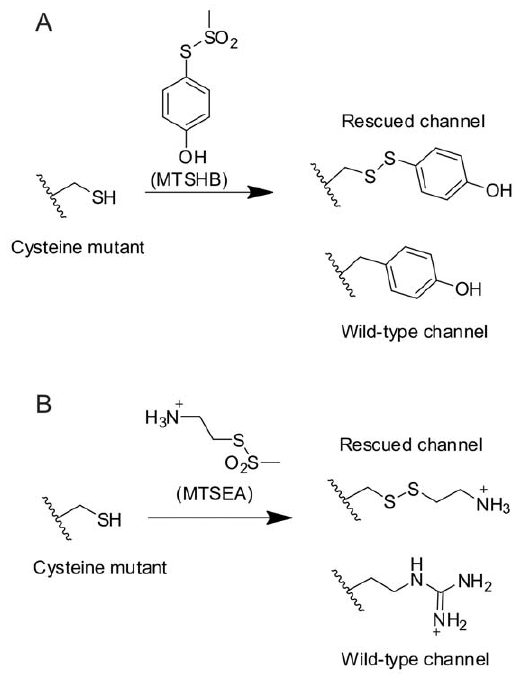
Figure 1. Rescuing strategy. A. Via a disulfide bridge, MTSHB attaches a hydroxyl benzene moiety that mimics tyrosine’s side chain. B. Via a disulfide bridge, MTSEA introduces a primary amine which mimics arginine’s side chain.